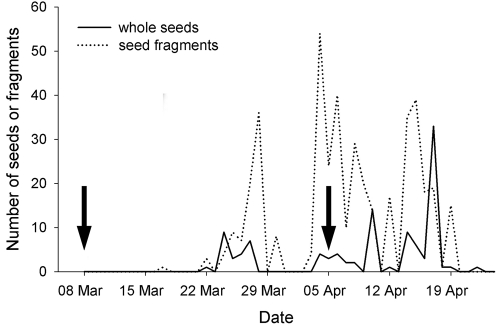
Gut-passage patterns of seeds and seed fragments of Syzygium mamillatum fruits fed to Aldabra tortoises.The two arrows indicate the beginning and the end of the feeding period, respectively.